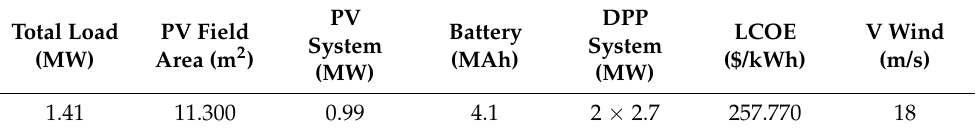
Table 1. Hybrid system profile at 100%